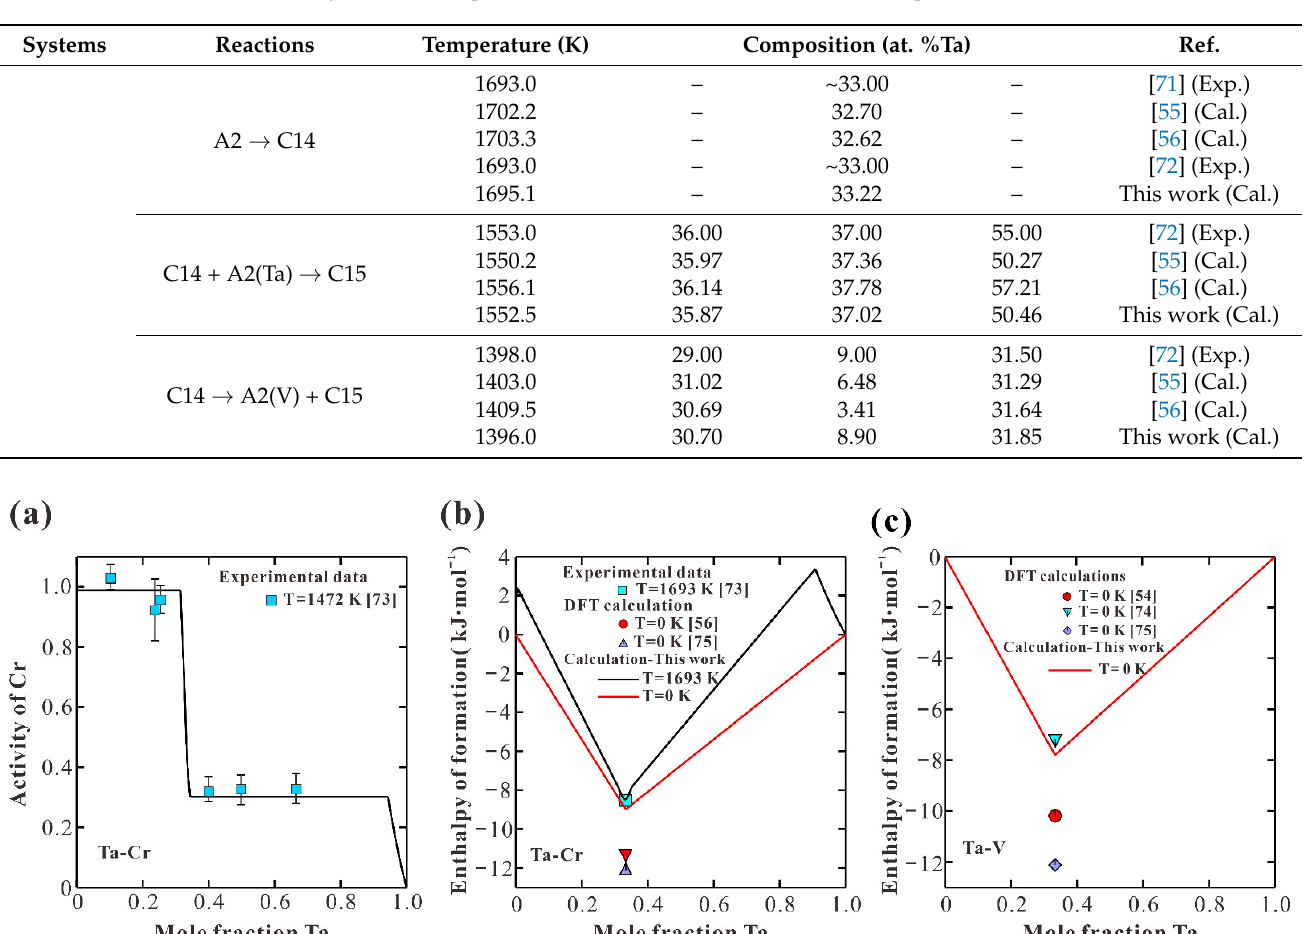
Table 3. Calculated temperatures and compositions of invariant reactions in Ta-Cr and Ta-V binary systems in comparison with the measured ones [67–72] and previous calculated ones [53–56].